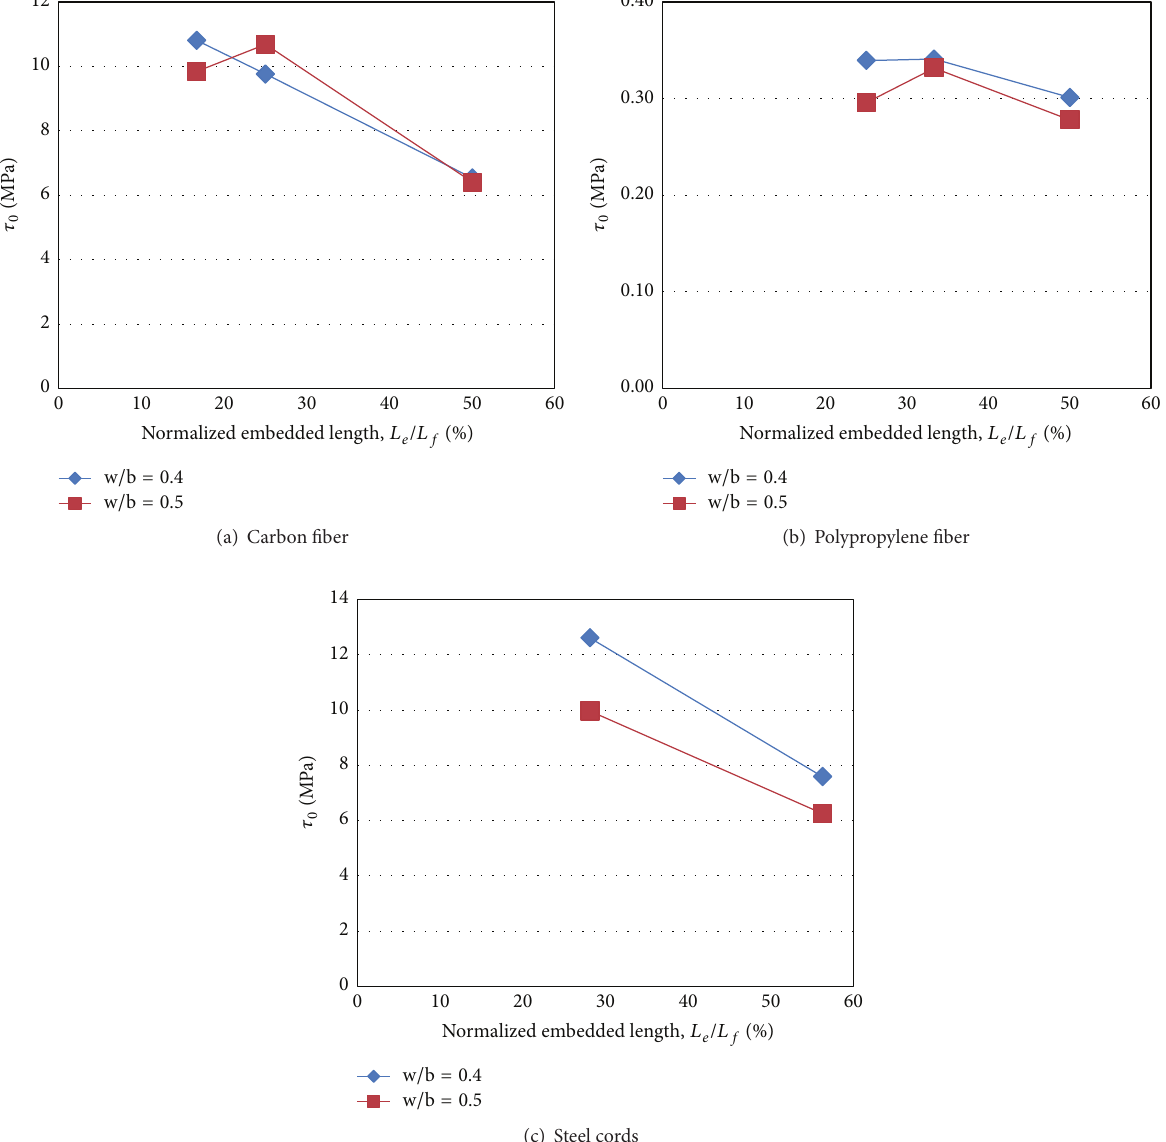
Figure 8: Frictional bond stress ( 𝜏 0 ) with respect to normalized embedment length ( 𝐿 𝑒 /𝐿 𝑓